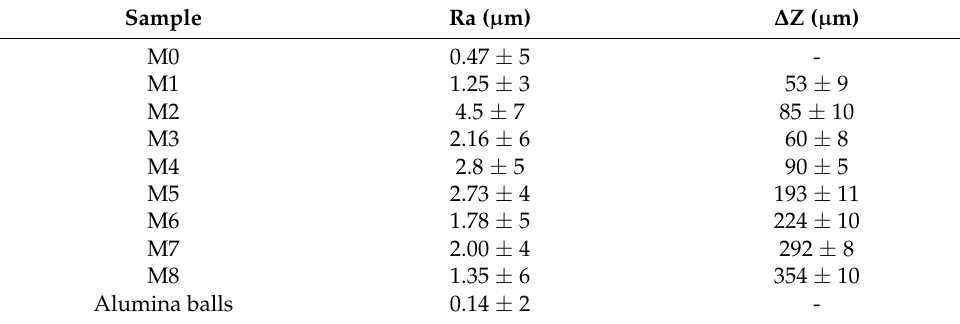
Table 6. Surface roughness and dimple depth of the employed samples.